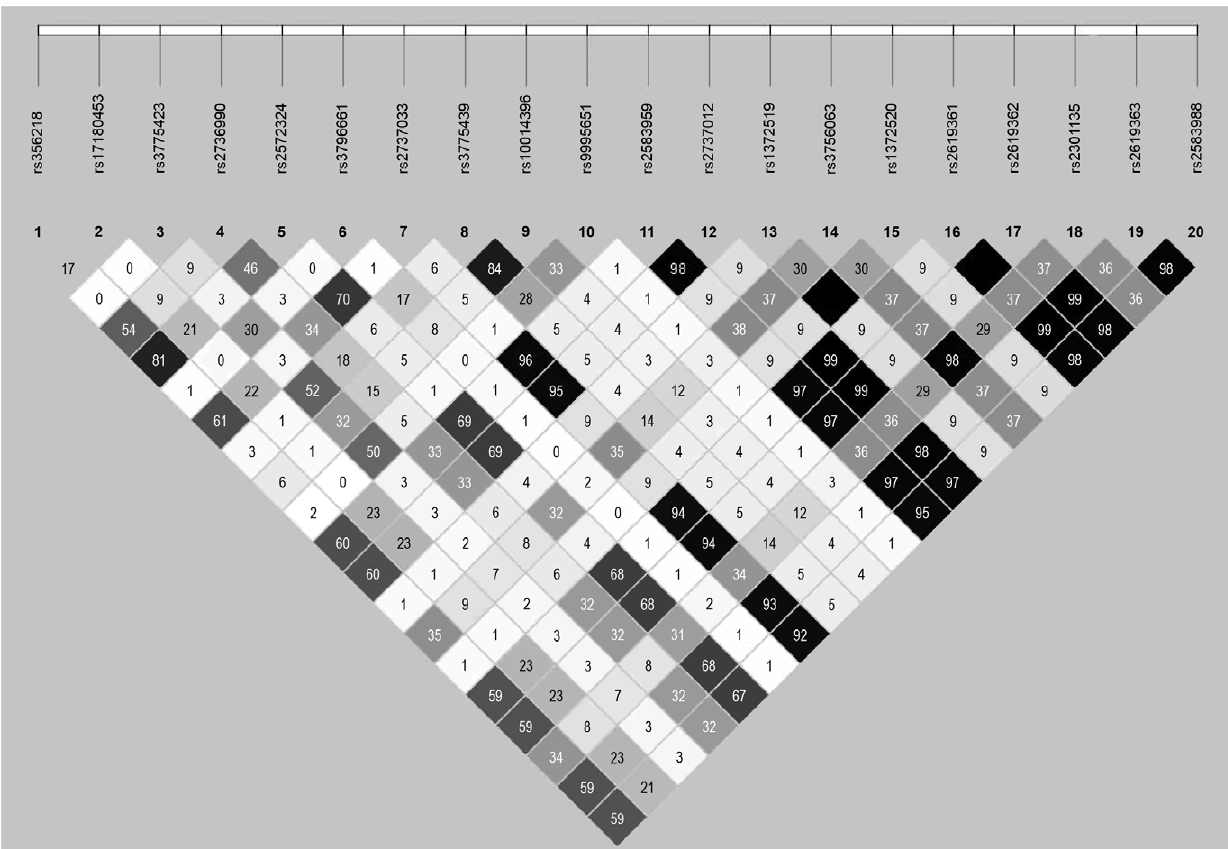
Figure 1. Linkage disequilibrium between SNPs in controls as measured by pairwise r 2 values. Values are given as percentages out of a maximum of 100. Solid black boxes indicate an r 2 value of 100.